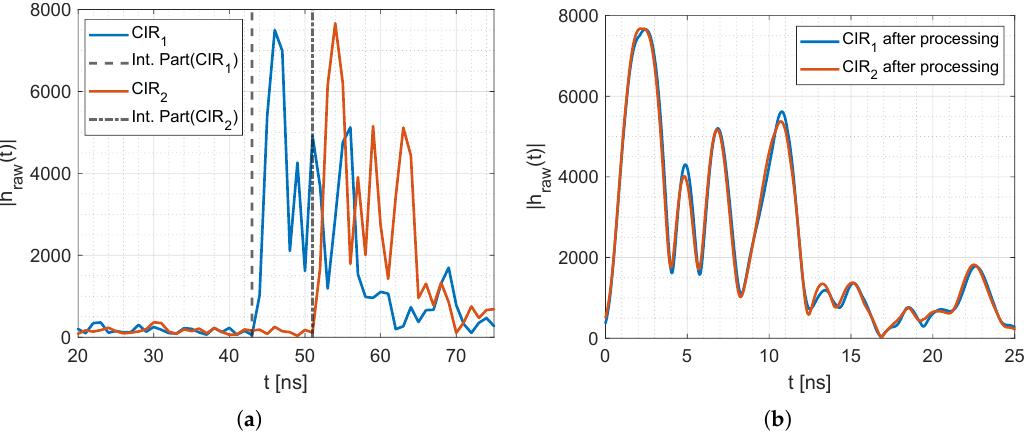
Figure 8. Measured and aligned CIR measurements. ( a ) Two consecutive CIR measurements. ( b ) CIRs measurements after